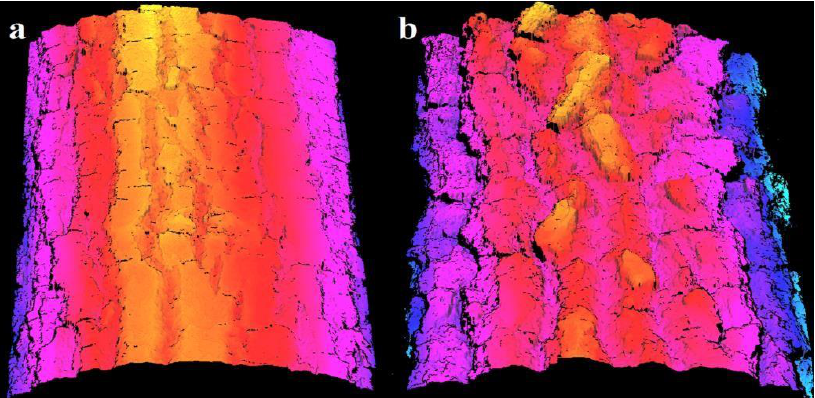
Figure 4. Three-dimensional images of oak bark surface made for two samples: ( a ) the upper part of the trunk and ( b ) the bottom part of the trunk.